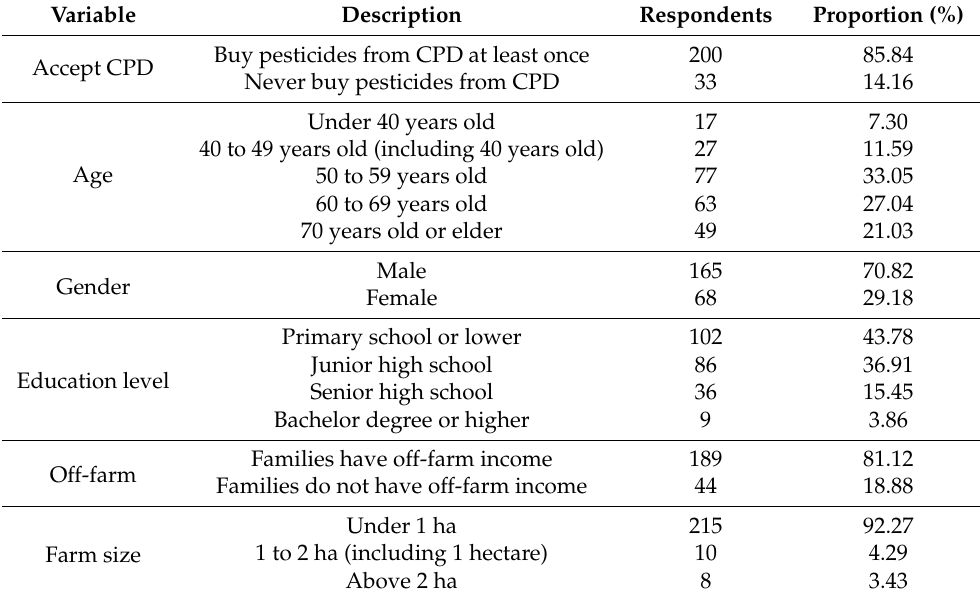
Table 3. Basic characteristics of